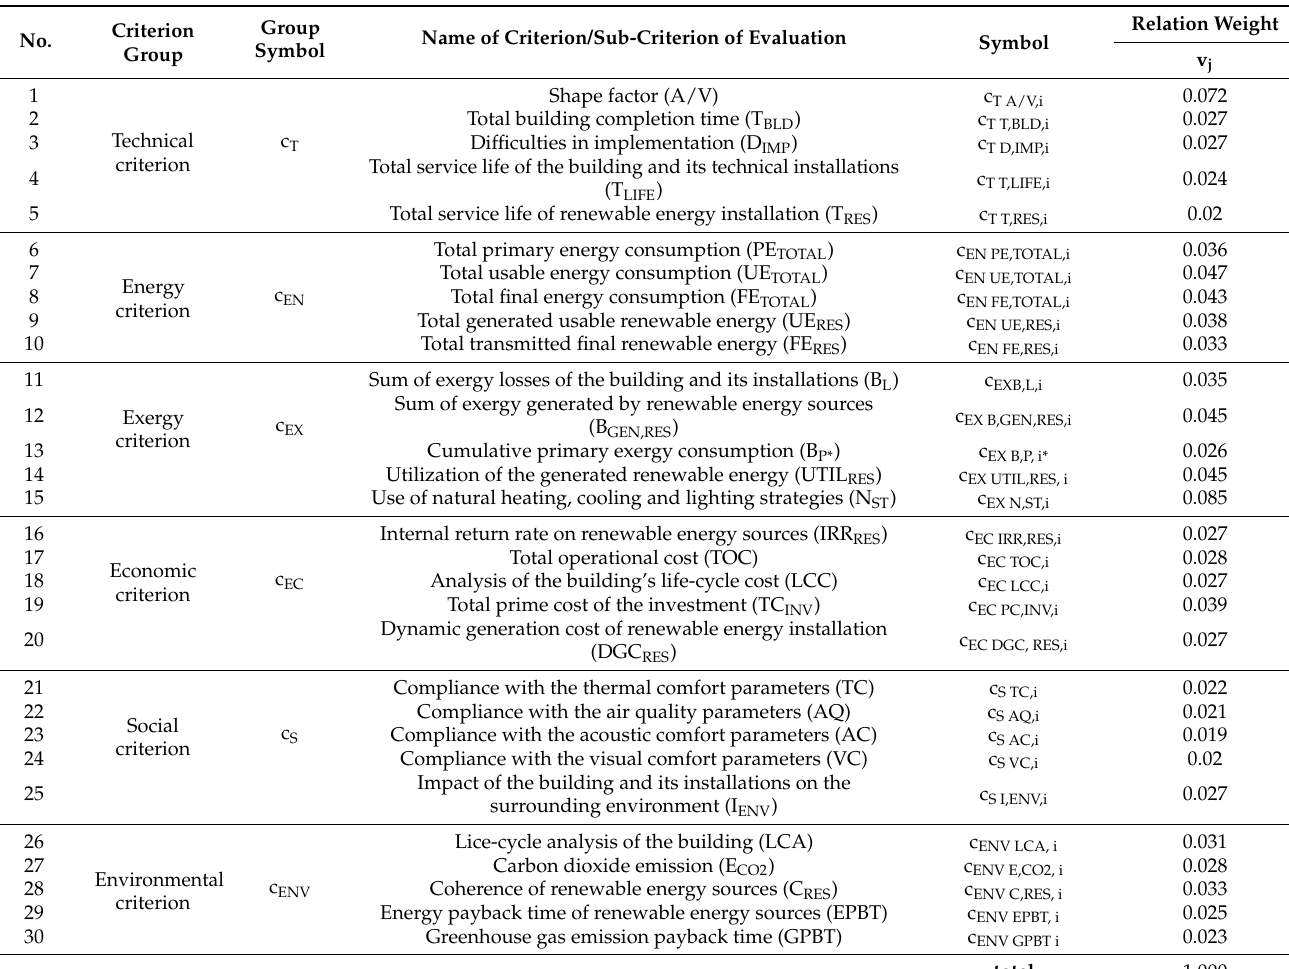
Table 2. Selected decision criteria for choosing a single-family residential building with a positive energy balance together with the relation